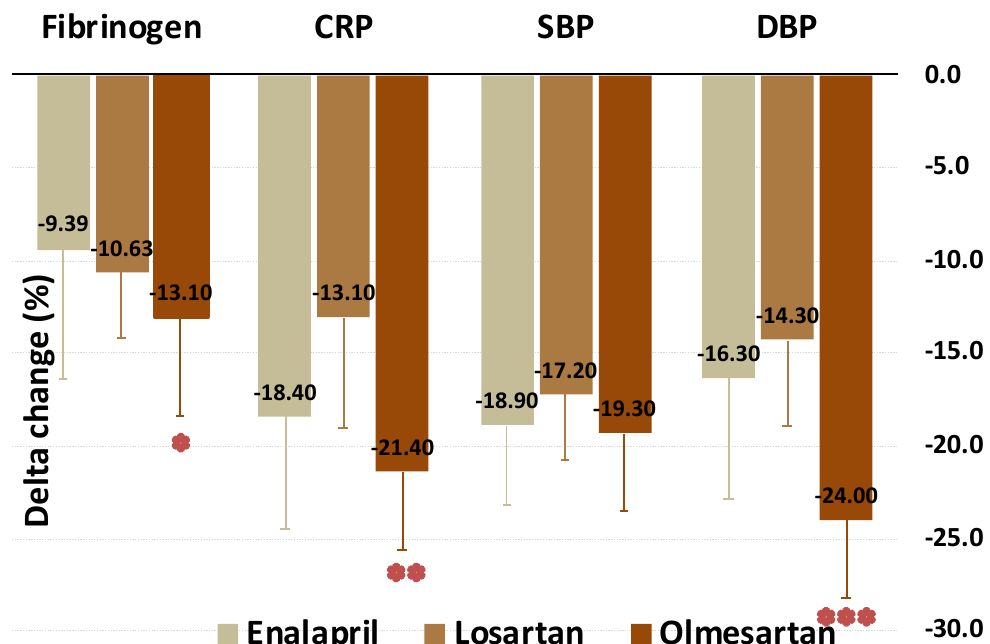
Figure 2. Change (%) of fibrinogen, CRP, SBP and DBP values by treatment with enalapril, losartan, and olmesartan. * Best, vs. enalapril; ** Best, vs. losartan; *** Best, vs. both enalapril and losartan.